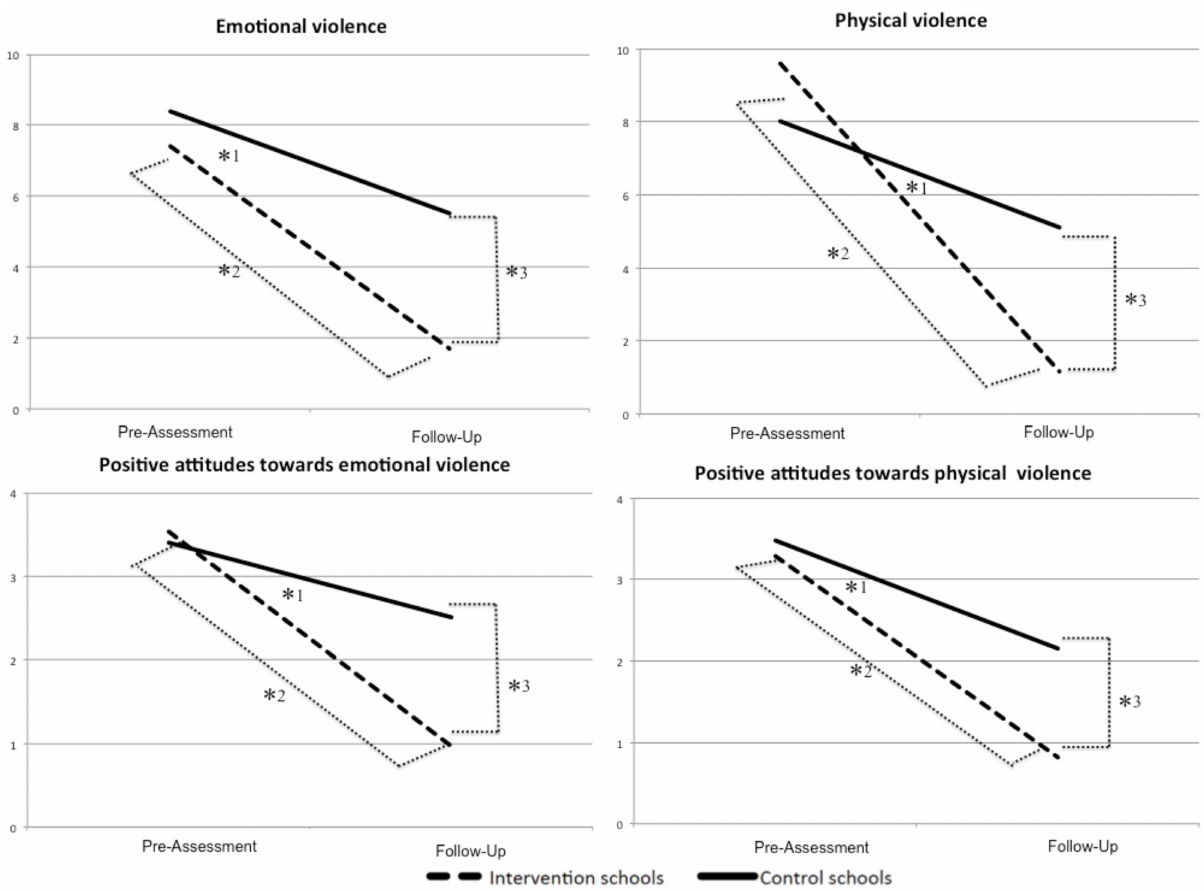
Fig 2. Use of emotional and physical violence against students and positive attitudes towards emotional and physical violence reported by teachers in intervention and control schools at pre-assessment and follow-up assessment. (cid:3) 1 significant interaction effect, (cid:3) 2 significant decrease from pre-assessment to follow-up in intervention group, (cid:3) 3 significant difference between intervention and control schools at follow up.